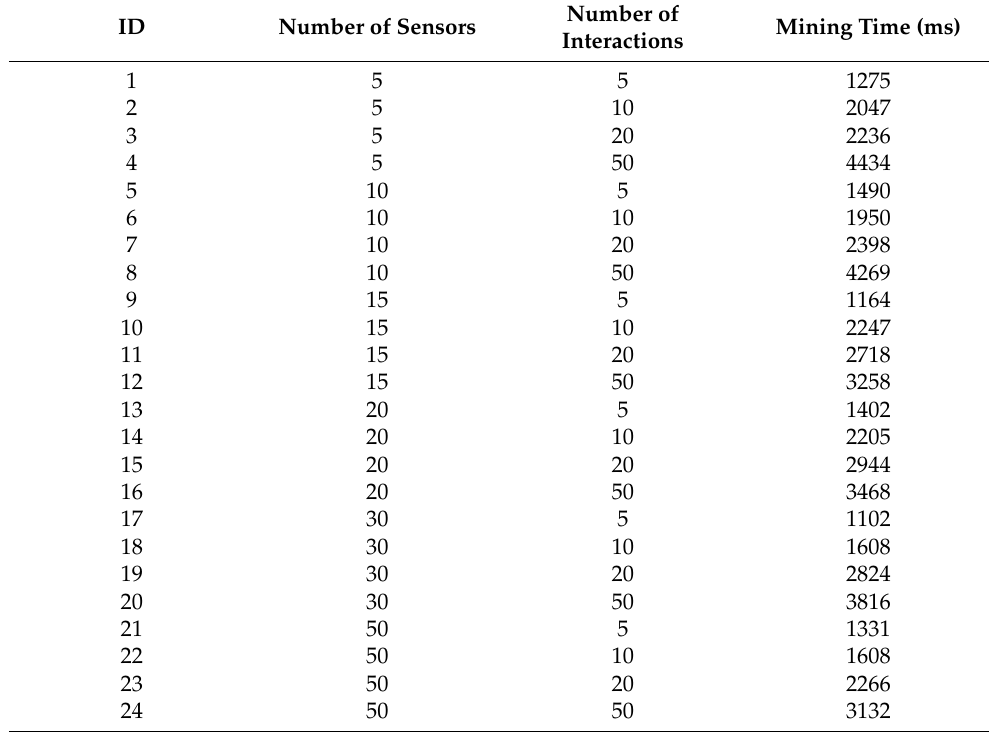
Table 5. Performance calculus for a single day of